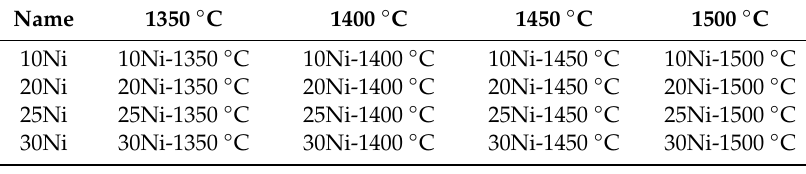
Table 4. Di ff erent sintering temperatures of Ti(C,N)-based cermets. Table 4. Different sintering temperatures of Ti(C,N)-based cermets.